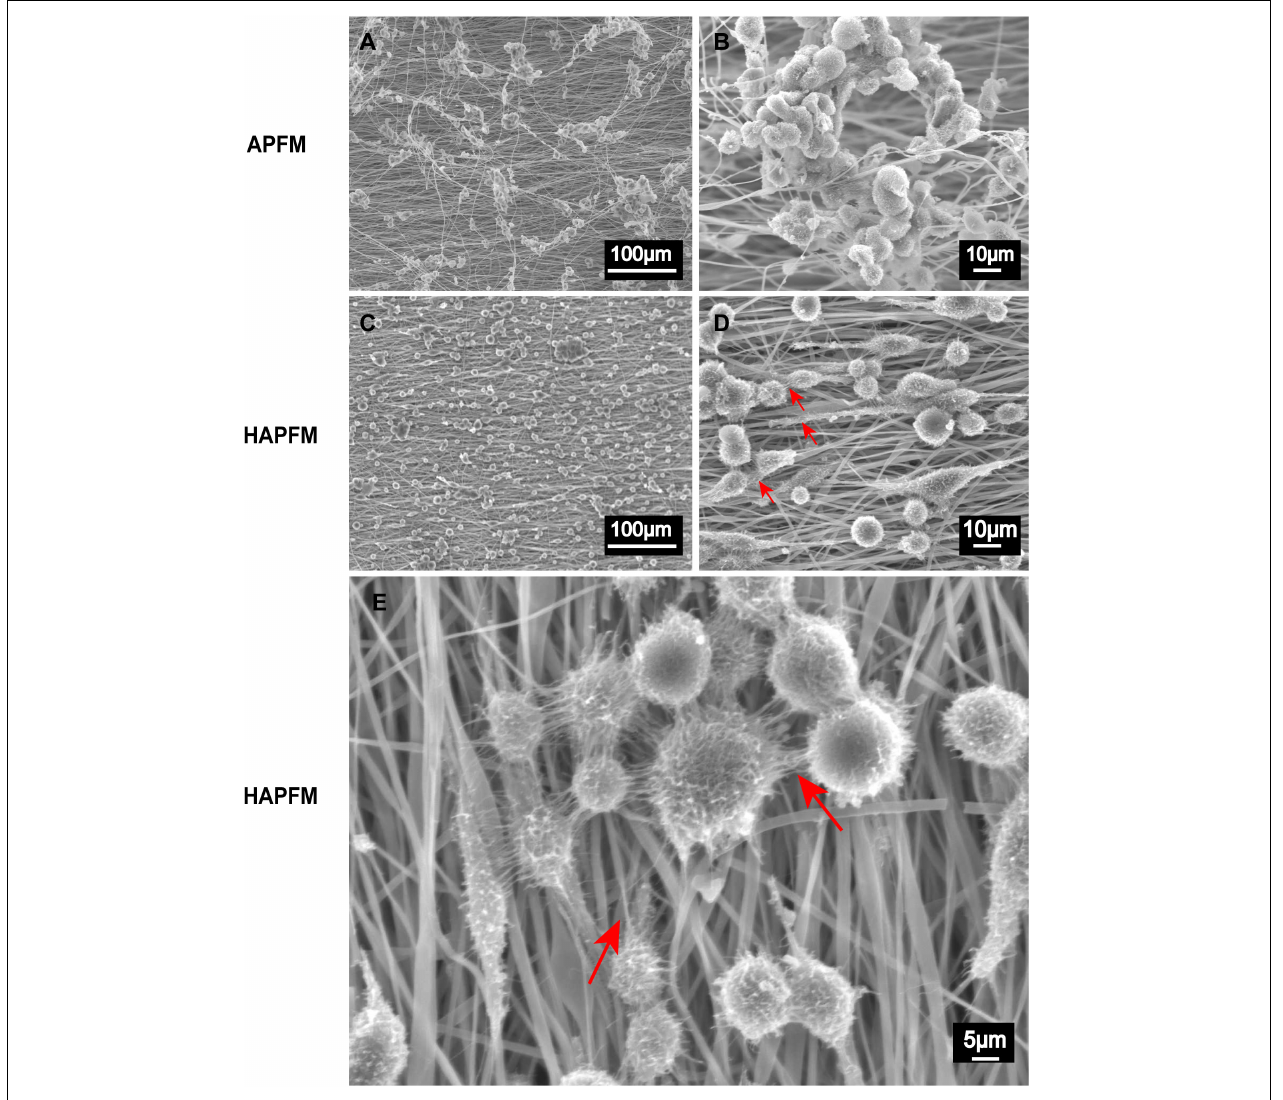
FIGURE 5 | SEM images APFMs and HAPFMs with RSC96 cells. (A,B) The RSC96 cells growing on APFMs were distributed in clumps. (C,D) The RSC96 cells growing on HAPFMs showed relatively uniform distribution with filopodia (red arrow). (E) The filopodia (red arrow) of amplified RSC96 cells on aligned HAPFMs. SEM, scanning electron microscope; APFMs, aligned poly ( L -lactic acid) fiber mats; HAPFMs, highly aligned poly ( L -lactic acid) fiber mats.